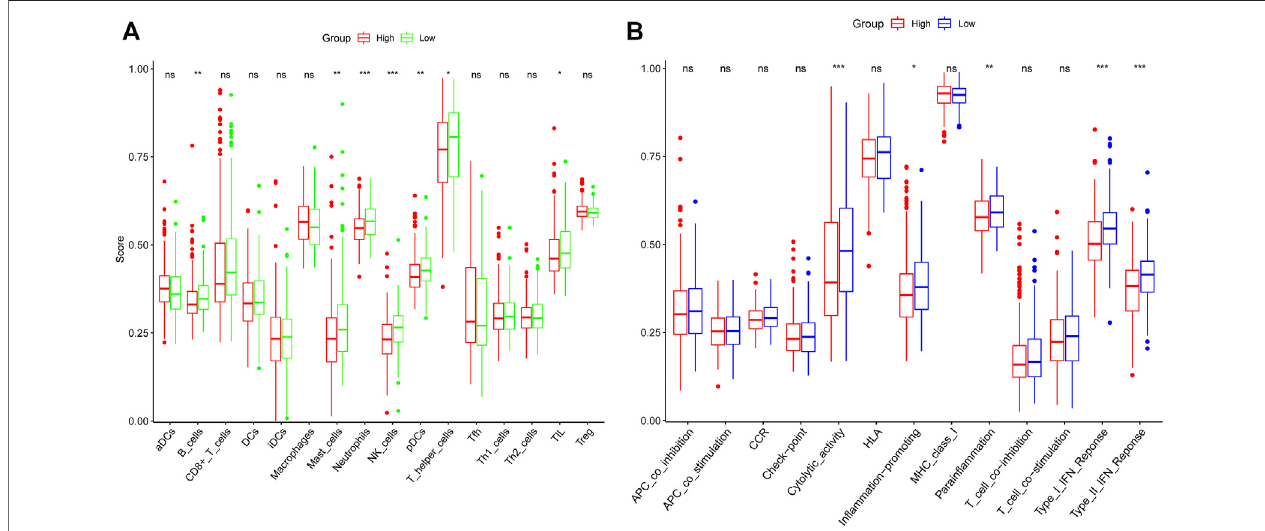
FIGURE6| Thesingle-sample geneset enrichmentanalysisscoresofdifferentriskgroups inthe derivation cohort werecompared.The scoresof16immunecells (A) and 13 immune-related functions (B) are displayed in